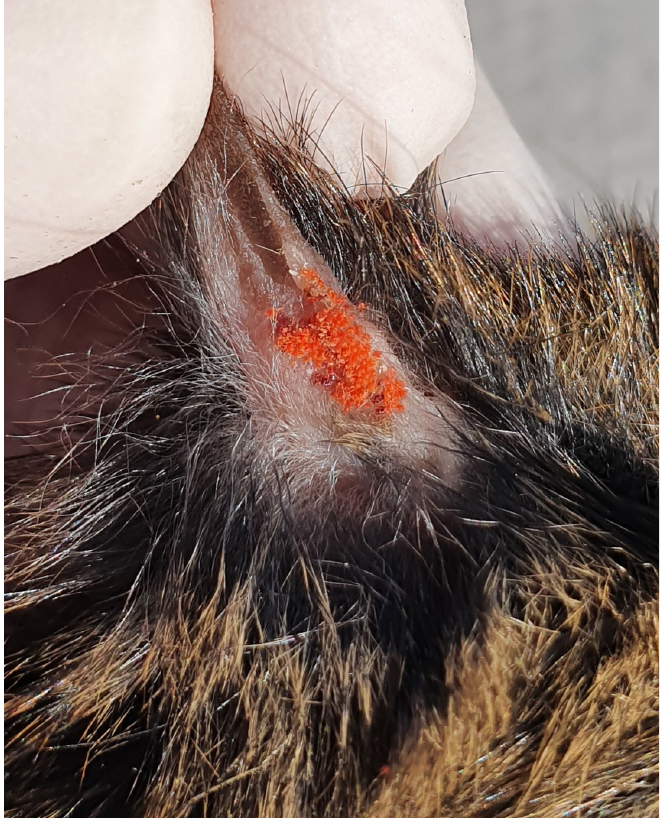
Fig 2. Trombiculid mites ( Herpetacarus antarctica ) at the base of the ear of Loxodontomys micropus from Tortel area.